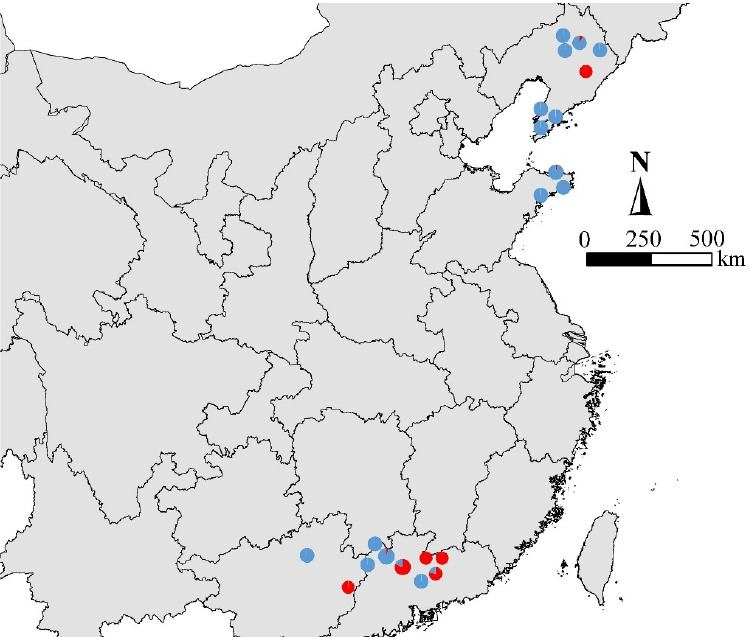
Figure 6. Population structure and genetic diversity of 21 pinewood nematode isolates (K = 2). Each color represents one ancestral population. Each isolate is represented by a pie chart, and the area of each color in the pie chart represents the proportion contributed by that ancestral population. FC isolate is the only red pie chart located in the upper right of the figure, surrounded by blue pie charts.